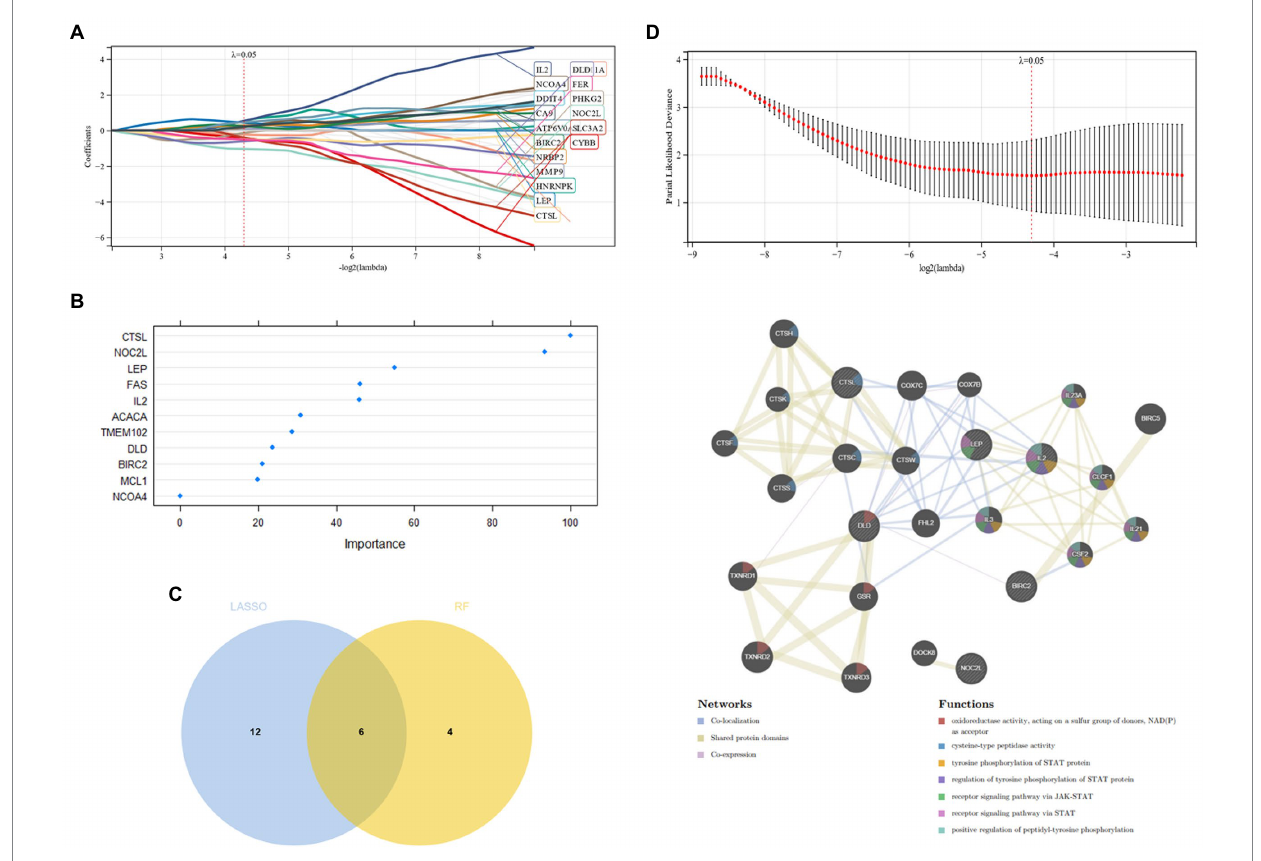
FIGURE 4 (A,B) Candidate gene screening via LASSO regression; (C) Differential expression profiling of candidate genes; (D) PPI network construction of candidate